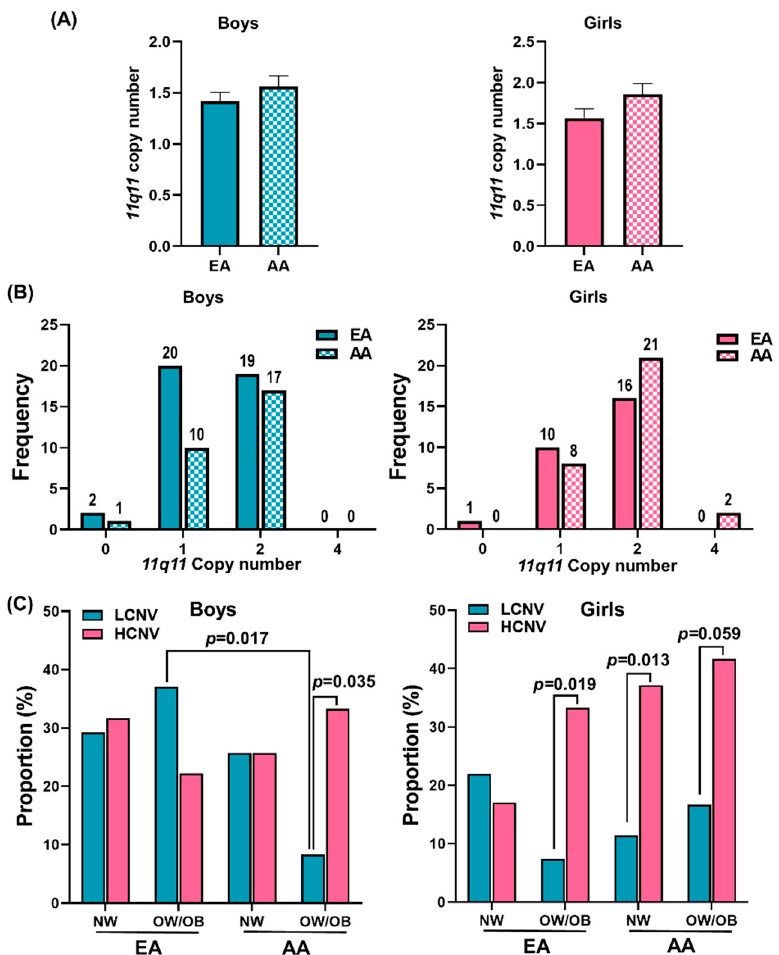
Figure 3. 11q11 copy numbers in boys and girls of White/European American (EA) and African American (AA) ethnicities. ( A ) The bar graphs represent the mean 11q11 copy number differences between gender-specific EA and AA participants. ( B ) Distribution of 11q11 copy number in the EA and AA boys and girls. ( C ) The differences among NW and OW/OB EA and AA participants of both genders in terms of LCNV and HCNV.